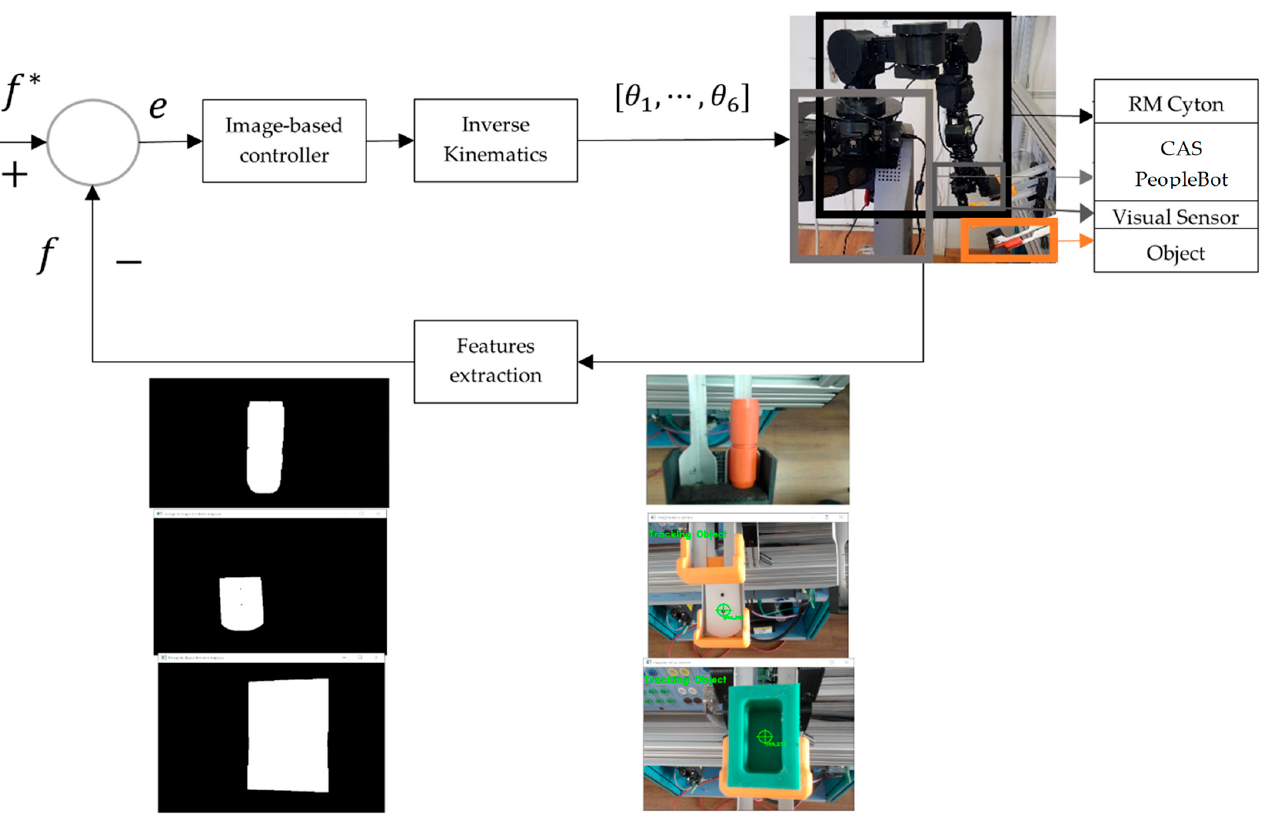
Figure 23. Closed-loop control of the RM Cyton based on eye-in-hand type VSS.